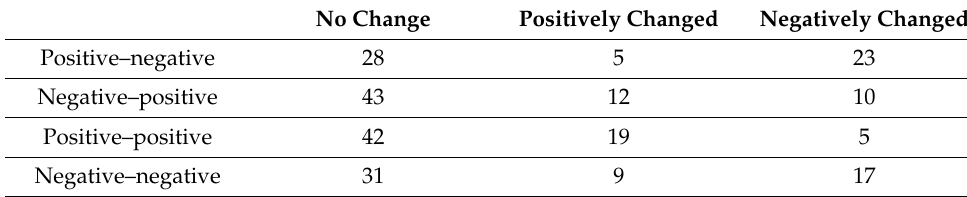
Table 1. Number of people who changed their